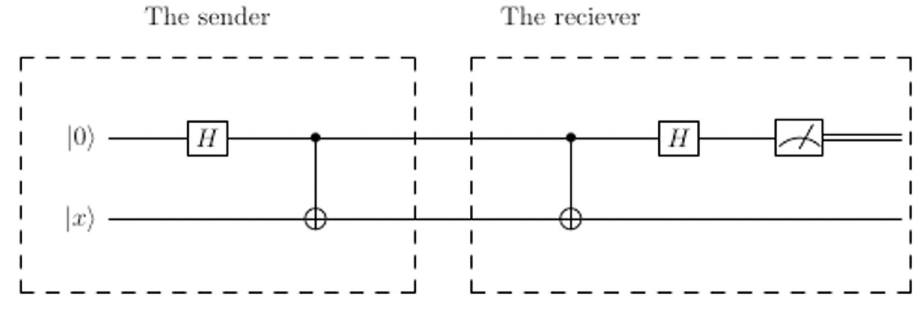
Fig 6. A quantum circuit to send binary-0 on the first qubit where the data is encoded as Bell state.